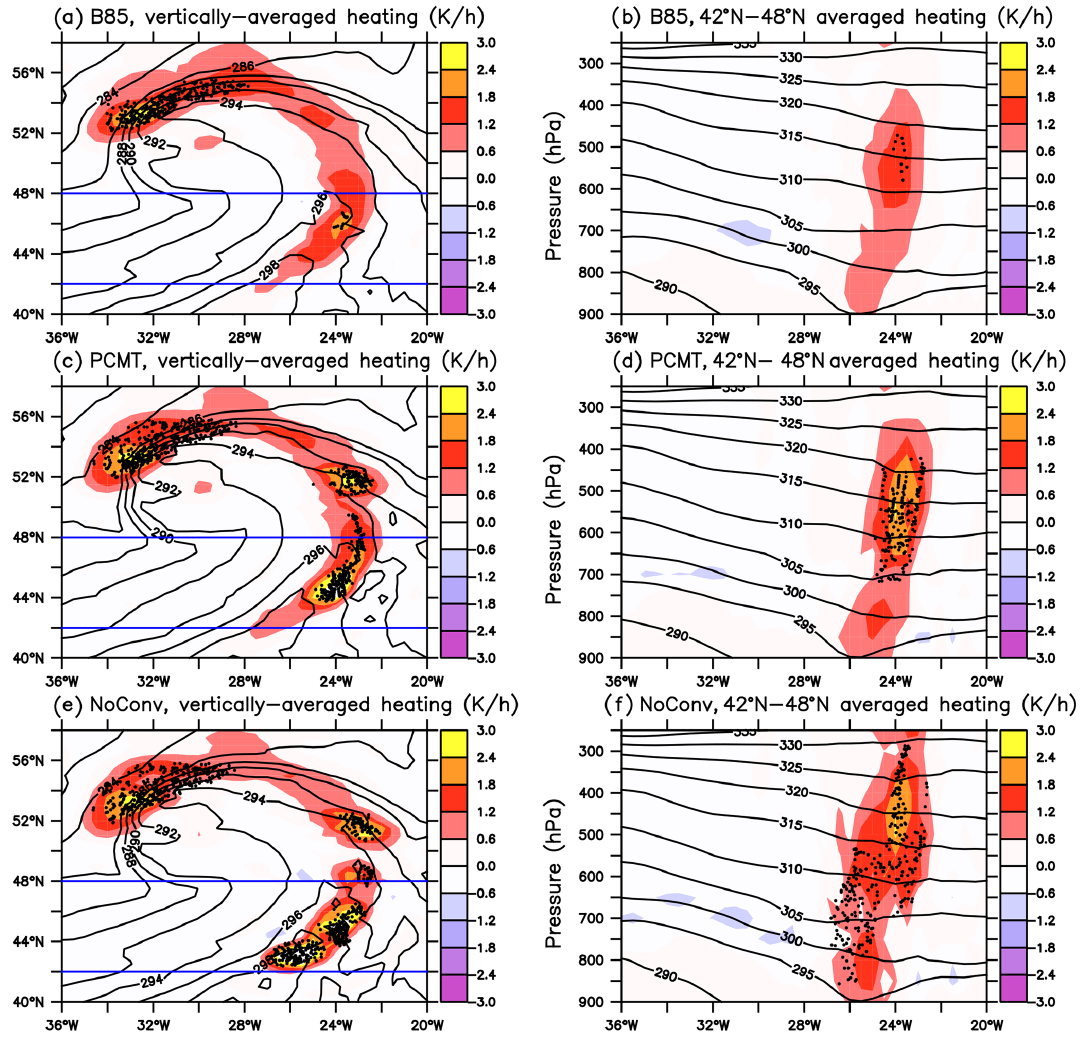
Figure 5. (a, c, e) Vertically averaged heating rate between 300 and 800hPa (shadings; units: Kh − 1 ), potential temperature at 850hPa (interval: 2K) and WCB trajectories satisfying 100hPa ascent in 2h at 21:00UTC on 1 October for (a) B85, (c) PCMT and (e) NoConv simulations. (b, d, f) Latitudinally averaged (42–48 ◦ N; see blue lines in panels a, c and e ) heating rate (shadings; units: Kh − 1 ), potential temperature (contours; interval: 5K) and WCB trajectories satisfying 100hPa ascent within 2h and located in the same latitudinal band at 21:00UTC on 1 October for (b) B85, (d) PCMT and (f) NoConv